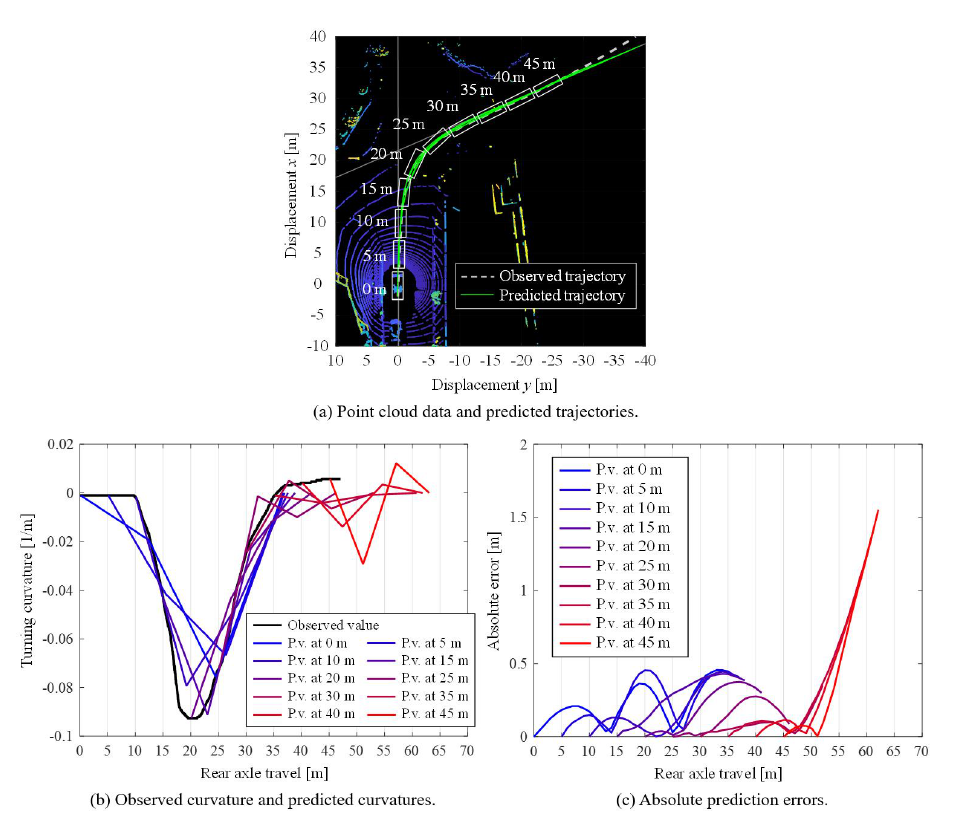
Figure 13. Prediction results with estimated distance parameter ˆ d pre from experiment at intersection ID